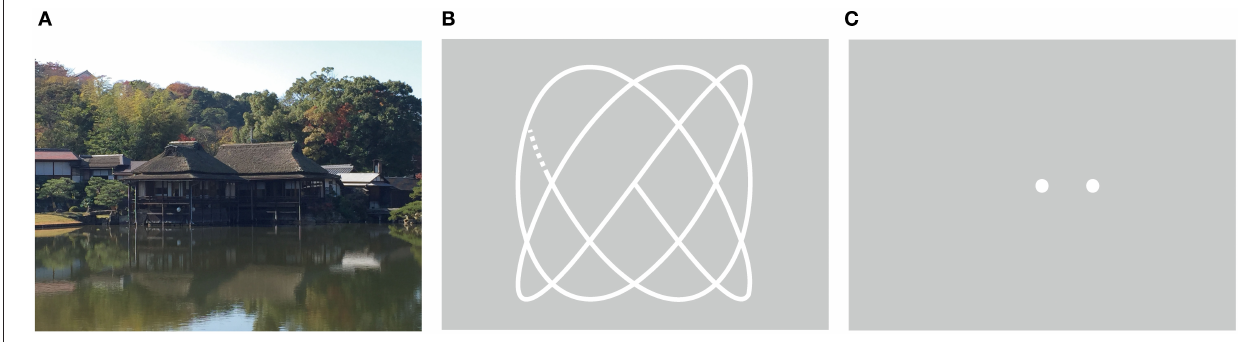
duration, amplitude, mean, and peak velocities of saccades.